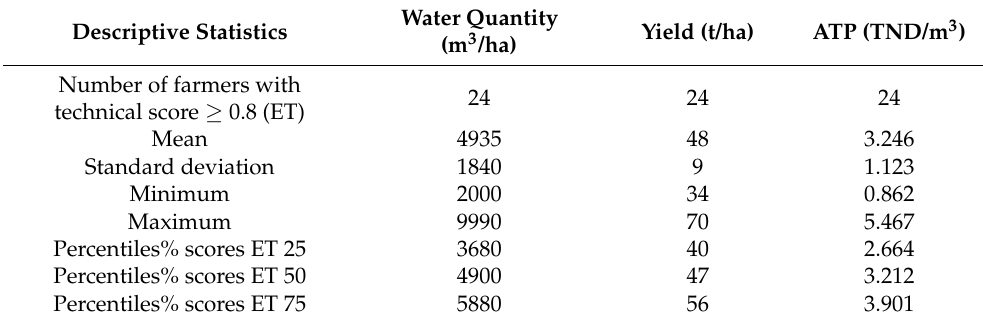
Table 1. Descriptive statistics of water used quantities, yields and ability to pay (ATP) for the most efficient farms (efficiency scores ≥ 0.8).